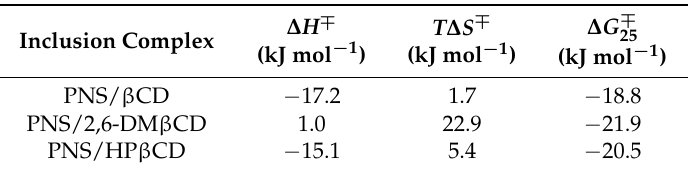
Table 2. Thermodynamics values of the three inclusion complexes derived from Van’t Hoff plots (R: gas constant, T: absolute